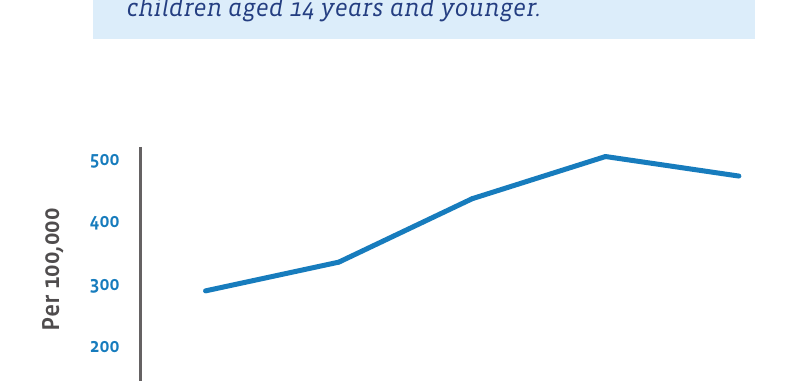
FIGURE 10: Annual Rate Estimates of Fall–Related Traumatic Brain Injury-Related Emergency Department Visits, Hospitalizations, and Deaths Among Adults Aged 65 and older, United States, 2002–2006 From 2002 to 2006, there was an increase in fall- related TBIs in emergency department visits among adults aged 65 years and